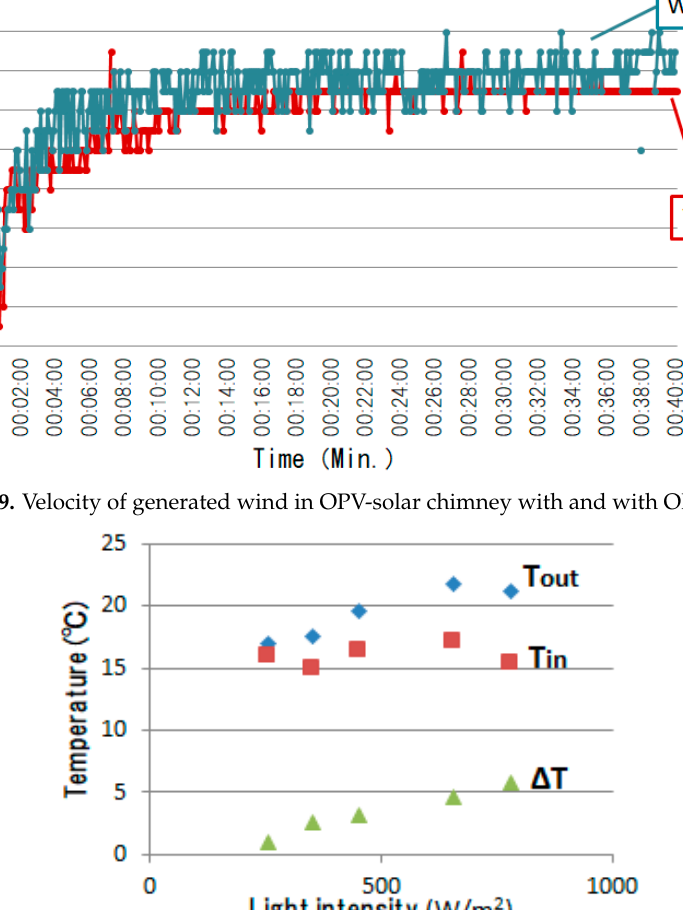
Figure 10. Inlet and outlet temperatures of OPV-solar chimney as a function of light intensity.